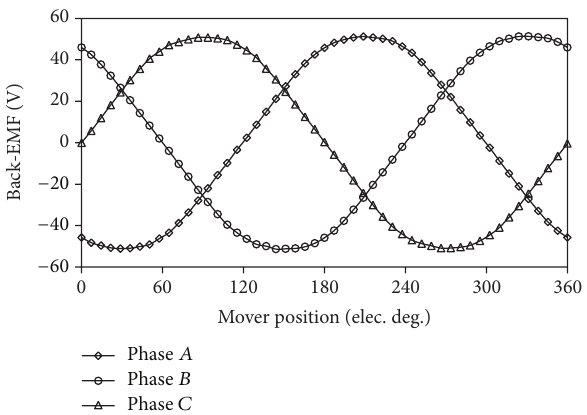
Figure 12: Comparison of detent forces based on both methods.